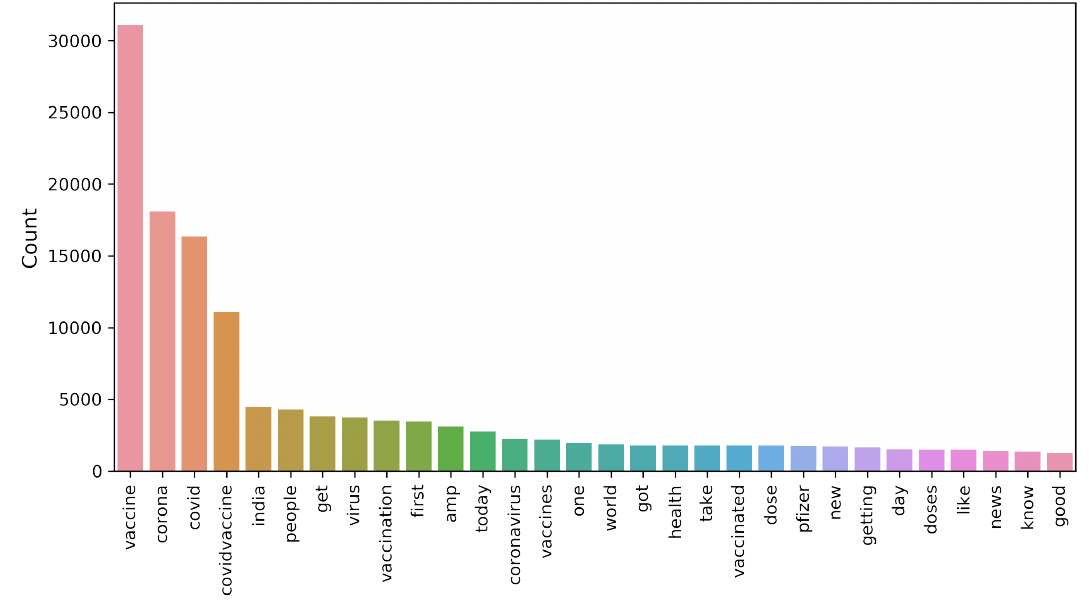
Figure 5. Chart for uni-gram terms from the collected